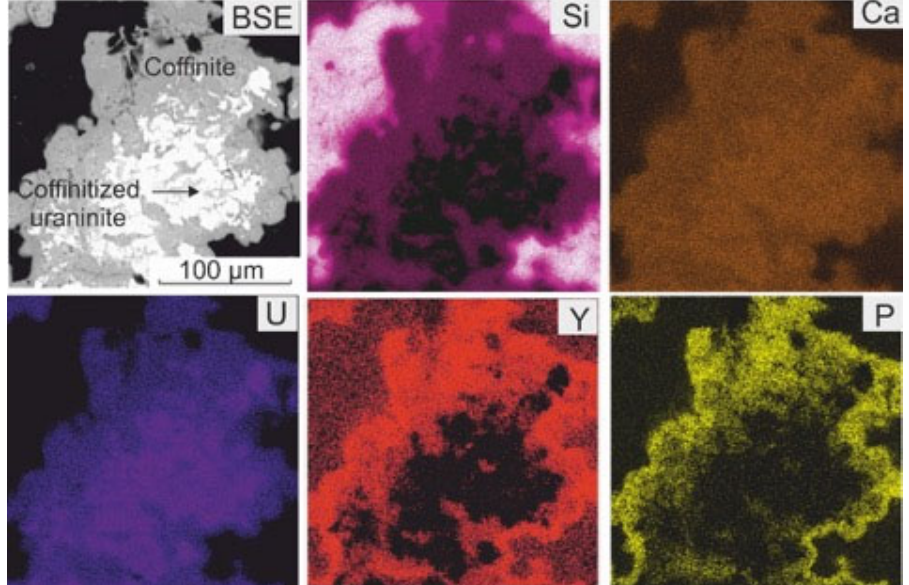
Figure 14. Corroded coffinite grain with a coffinitized remnant of uraninite (BSE) in the quartz ‐ rich part of the synchysite ‐ bearing vein in the Rožná uranium deposit and the areal distribution of Si, Ca, U, Y, and P within the grain (false colors).